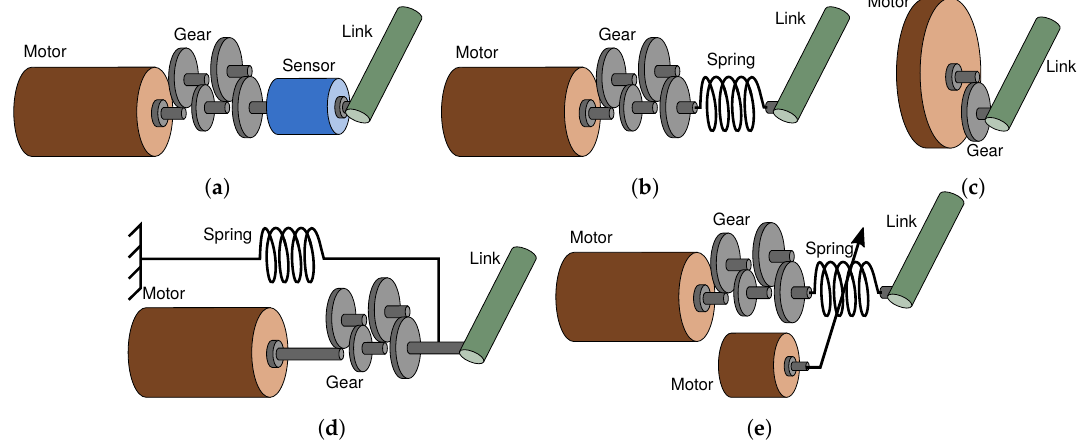
Figure 1. Illustration of five compliant actuators. The figures are replicated from the three corresponding figures in [1]. The sample delay listed below refers to the delay, between an occurring impact to an opposing force that has been applied, introduced using a digital impedance